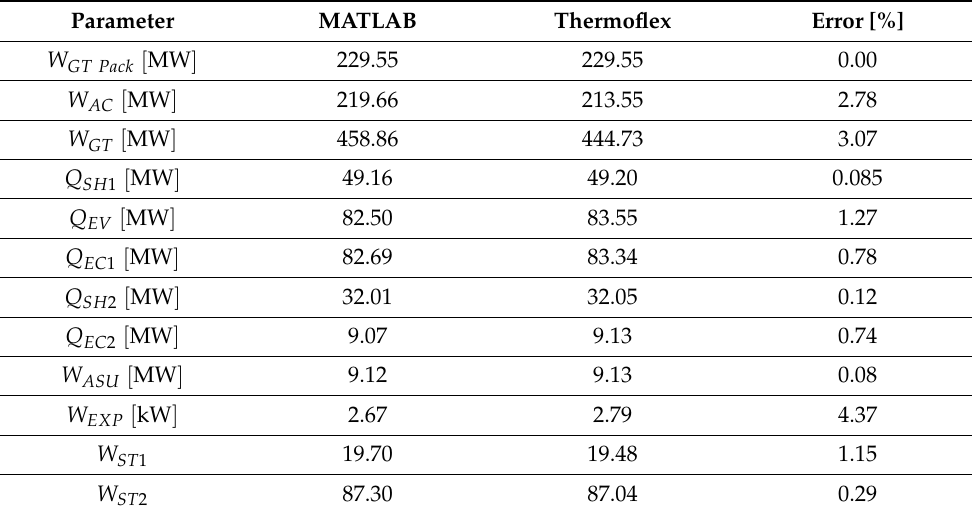
Table 3. Power and heat transfer rates for different components obtained from simulations in MATLAB and Thermoflex software. Parameter